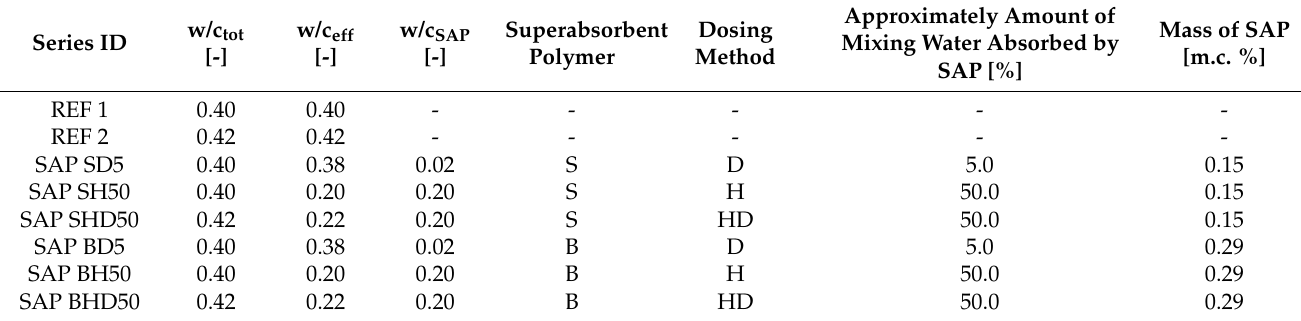
Table 3. List of prepared reference and SAP-modified concrete